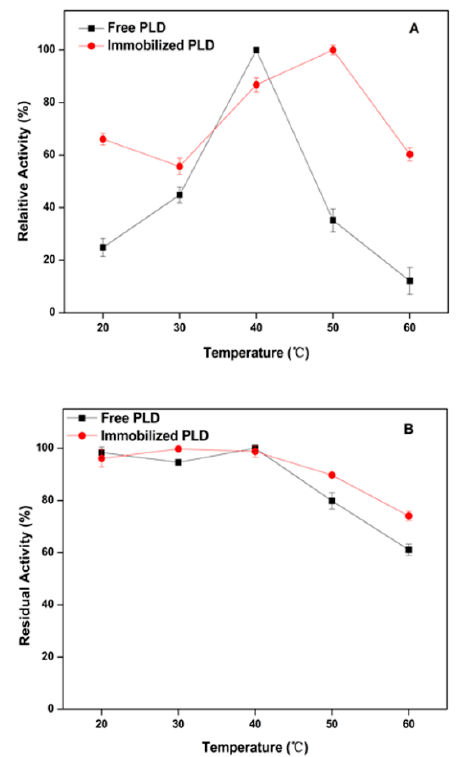
Figure 5. Effect of temperature on the enzyme activity (A) and stability (B) of the free and immobilized PLD a2